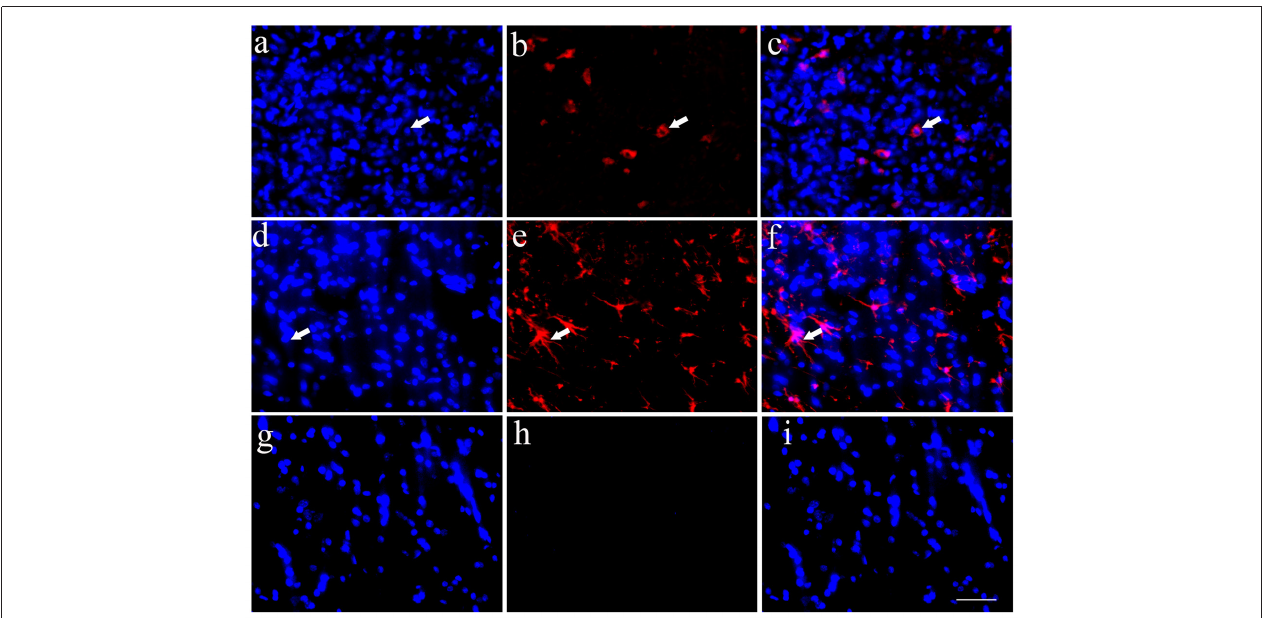
FIGURE 4 | Transplanted HSCs could differentiate into neurons and glia like cells in vivo . (A) Positive HSCs with blue staining in nucleus marked by Hoechst 33342 in the spinal cord could be seen after HSC transplantation. (B) A few of HSCs could differentiate into neurons with Tuj1 positive staining (red). (C) The merged picture of Tuj1 and Hoechst 33342, the positive ratio of Tuj1/ Hoechst 33342 is about 3.1%. (D) Positive HSCs with Hoechst 33342 blue staining. (E) A few of HSCs could differentiate into astrocytes with ALDH1L1 positive staining (red). (F) The merged picture of ALDH1L1 and Hoechst 33342, which showed the positive ratio is about 18.3%. (G) Hoechst 33342 blue staining in the negative control (no primary antibody). (H) There is no positive red staining in the negative control (no primary antibody). (I) The merged picture. Bar = 50 µ m. White arrows represented the positive cells. The positive ratio of Tuj1 (Tuj1/ Hoechst 33342) and ALDH1L1 (ALDH1L1/Hoechst 33342) was quantified using Image-Pro Plus 6.0 software ( n = 7).